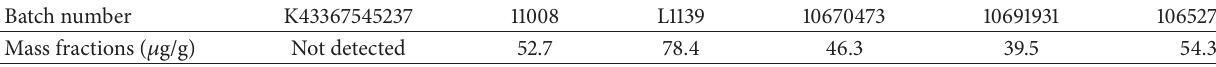
Table 2: Detected contents of 𝛼 -La ( 𝜇 g/g) in six commercial lactose samples from different sources.